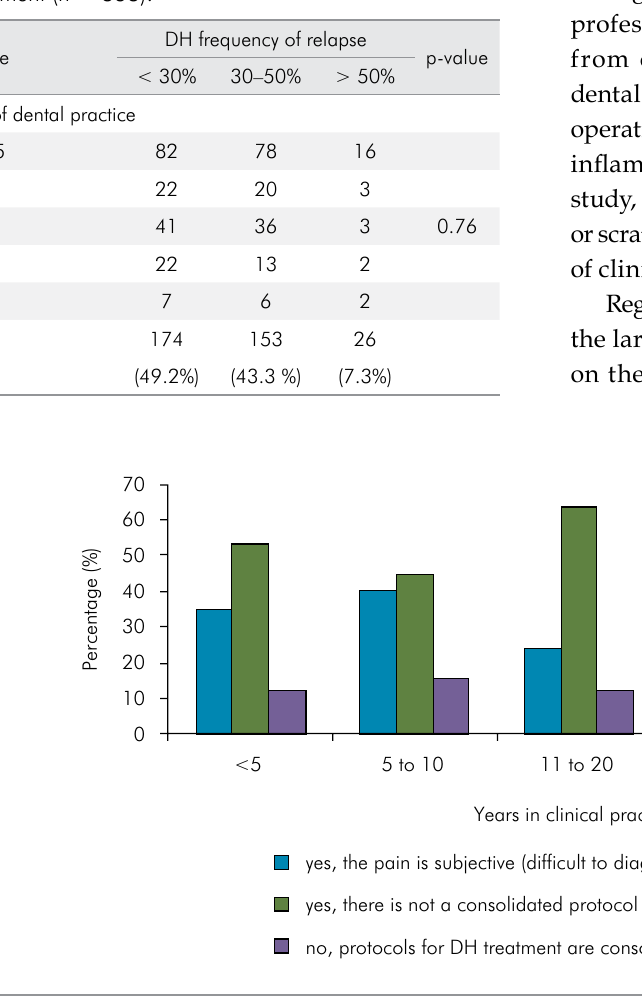
Figure 3. Dental practitioners’ responses to the question: “Do you consider the management of dentin hypersensitivity a challenge in your daily clinical practice?” presented according to their years of dental practice.